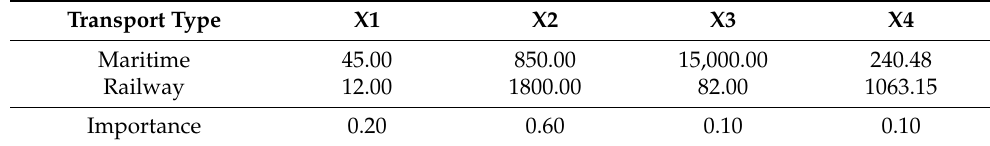
Table 5. Decision matrix for 82 loading units.